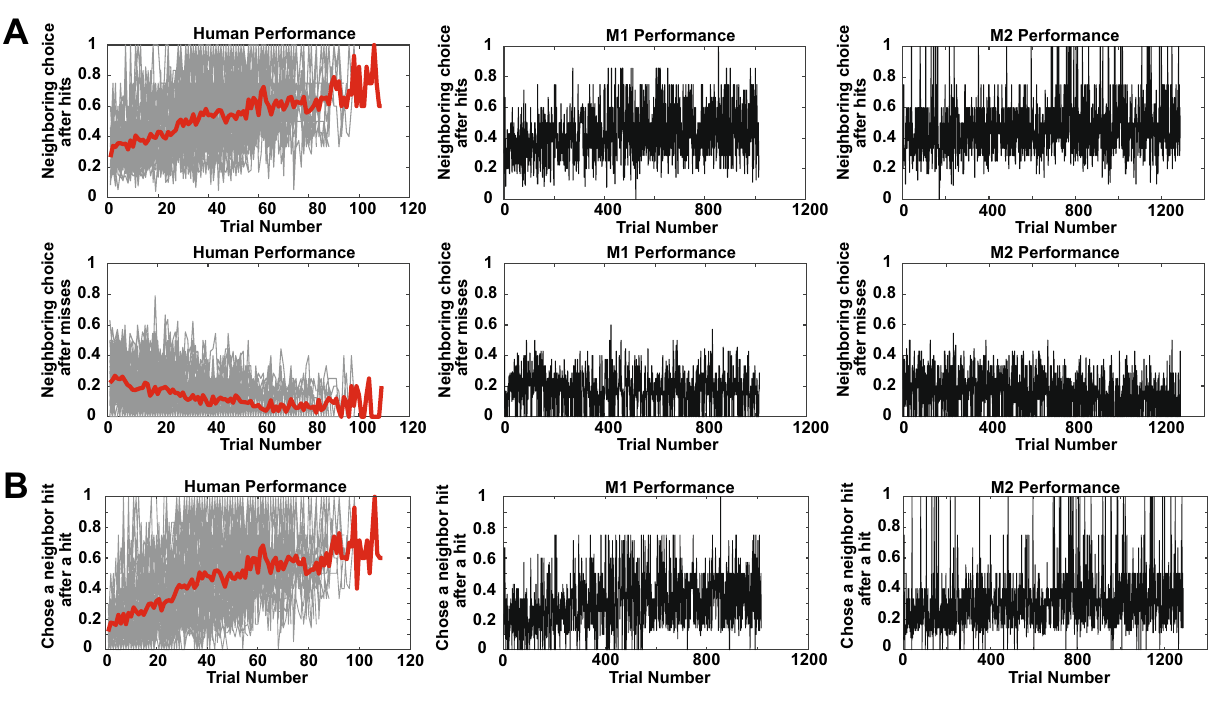
Figure 4. ( A ) Probability of choosing a neighboring tile after a hit (left column) or a miss (right column). First row: humans; second: M1; third: M2. ( B ) Probability of choosing a neighboring hit after a hit. Left: humans; middle: M1; right: M2. All plots: thick red lines are average probability of choice; gray lines are individual human participant